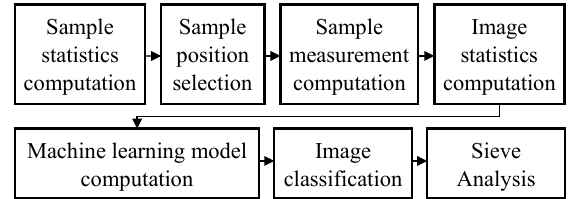
Figure 4. Pixel-based image classification workflow